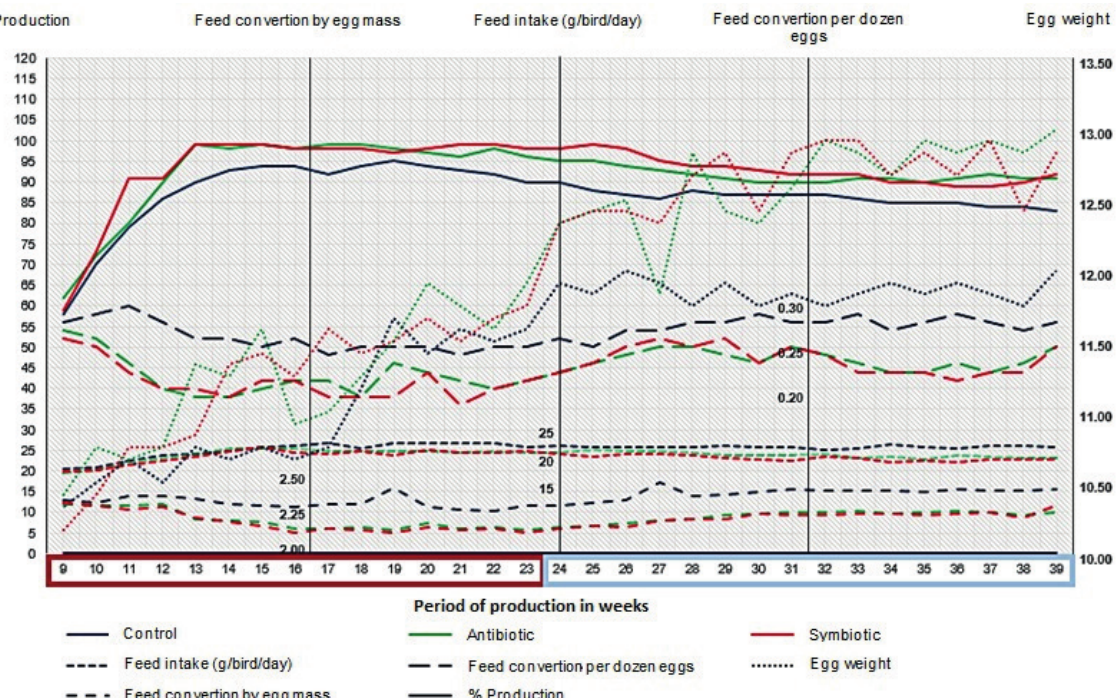
Figure 1 - Performance of quails fed with different additives during two production